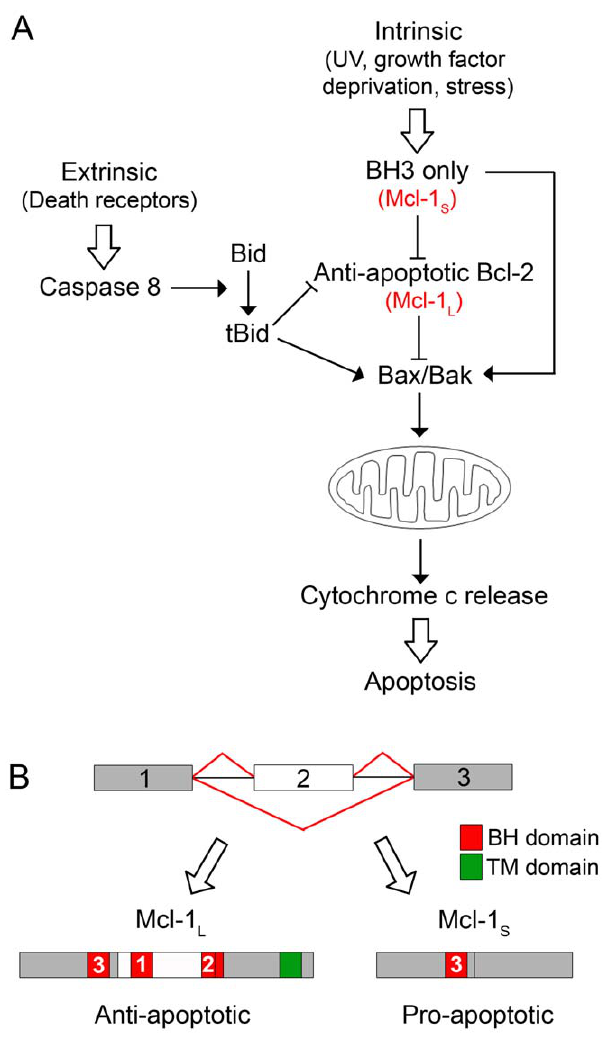
Figure 1. Pathway to show how Mcl-1, a member of the Bcl-2 family, influences apoptosis. ( A ) The intrinsic (mitochondrial) cell death pathway is controlled by the Bcl-2 protein family, including BH3- only proteins, anti-apoptotic Bcl-2 proteins, Bax, Bak and Bid. ( B ) The Mcl-1 gene consists of three exons; the anti-apoptotic Mcl-1 L and the pro-apoptotic Mcl-1 S protein isoforms result from inclusion and skipping of exon 2 (open box), respectively.